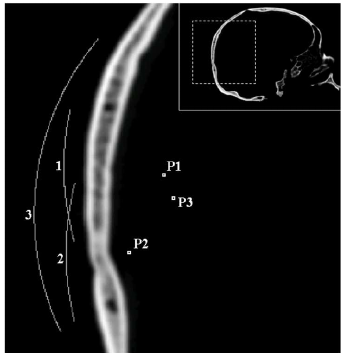
Figure 1. Schematic sagittal cross section of the skull, representing the positions of target points ( P1 , P2 , P3 ) and registration surfaces ( 1 , 2 , 3 ) considered in numerical simulations.